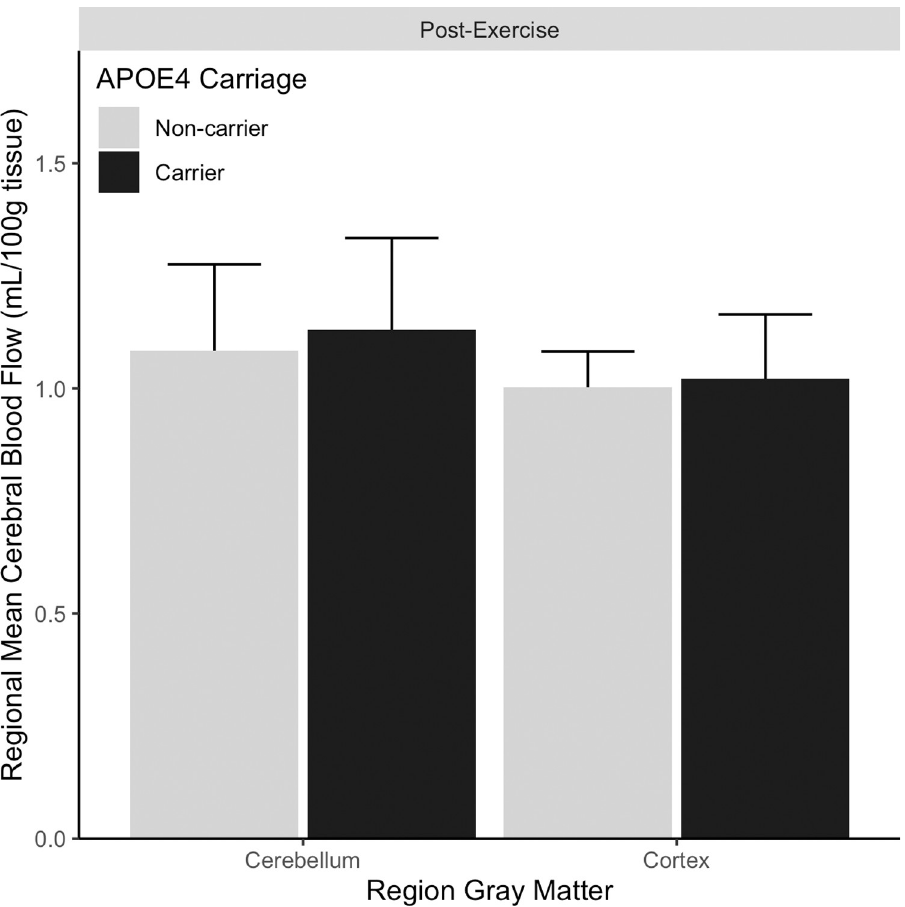
Fig 2. Cerebral blood flow area under the curve does not differ after exercise based on APOE4 carriage. Total cerebral blood flow following exercise is plotted for both the primary region of interest, cortical gray matter, and the cerebellar gray matter reference region. Black bars denote APOE4 carriers. Gray bars denote APOE4 non-carriers. Error bars are standard deviation.